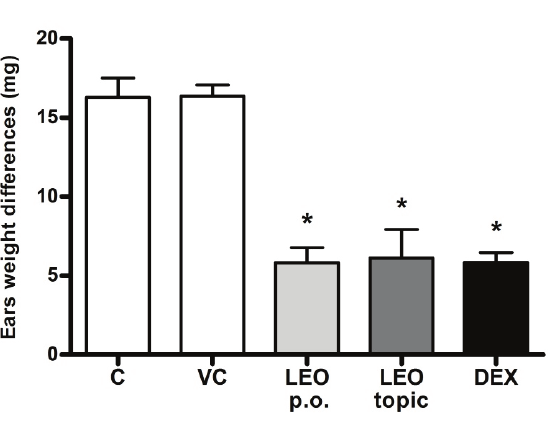
Figure 4 - Dose- and time-response curves of flinches induced by injection of formalin 2% s.c. into the surface of the right hind paw. Effect of treatments on the nociceptive behavior. ( a ) Lavender essential oil 0.6 g/kg, p.o., 1 hour prior. ( b ) Tramadol 30 mg/kg, p.o., 1 hour prior. ( c ) Indomethacin 5 mg/kg, p.o., 1 hour prior. Values represent the mean ± SEM. * p < 0.05 compared to the formalin